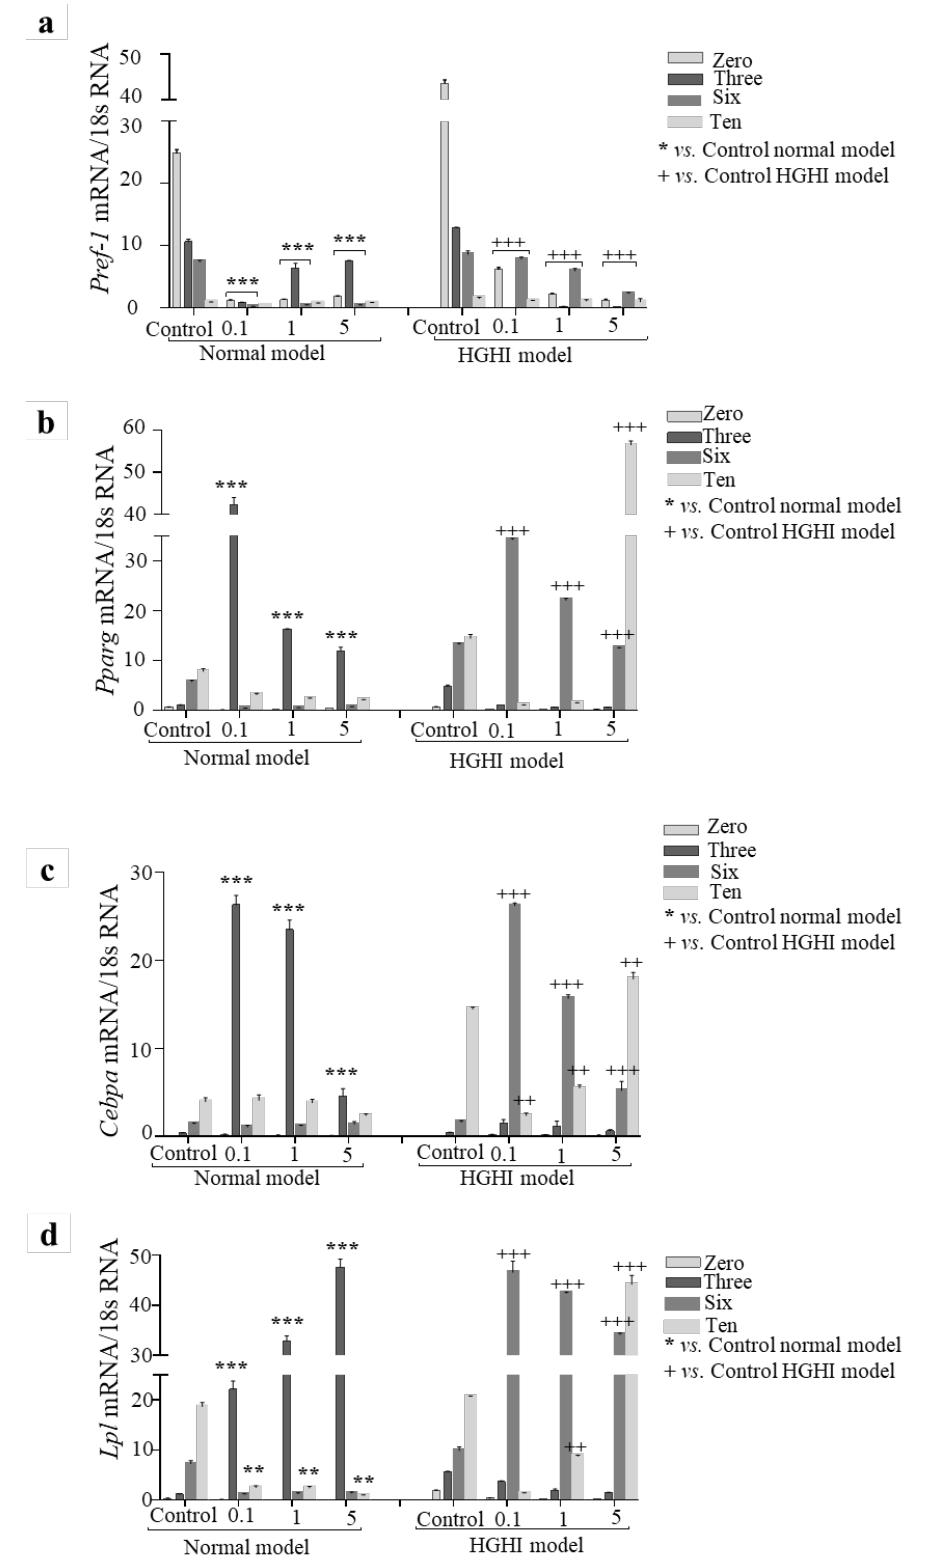
Figure 5. Adipogenesis. Expression of ( a ) Pref-1 , ( b ) Pparg , ( c ) Cebpa , and ( d ) Lpl in adipocytes in normal and pathological models at differentiation days zero, 3, 6, 10 and treated or not with the carvone chemotype L. alba EO. ** p < 0.01; and *** p < 0.001; ++ p < 0.01; and +++ p < 0.001 with respect to the pathological model without EO treatment.